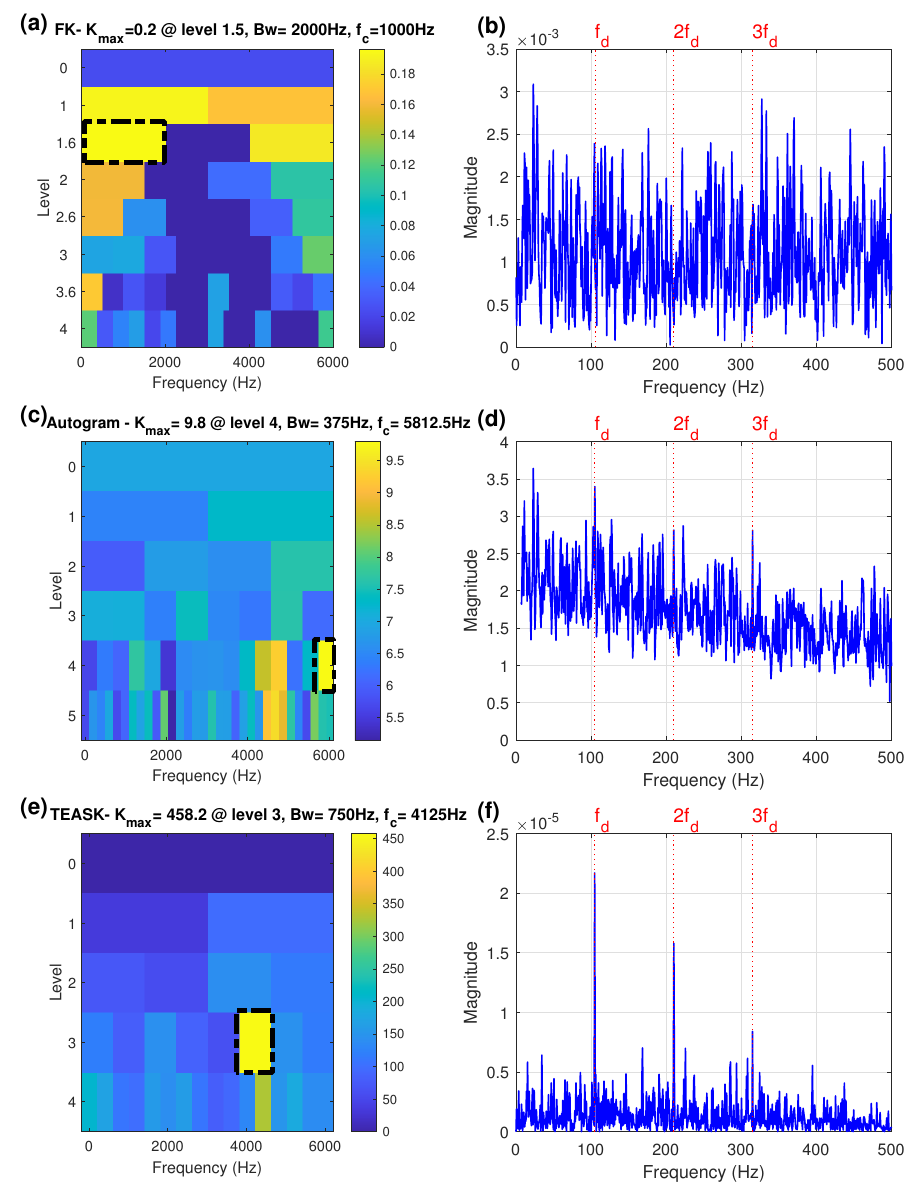
Figure 4. The simulation signal ( a ) the FK, ( b ) the SES obtained by the node with highest kurtosis of the FK, ( c ) the Autogram, ( d ) the combined SES obtained by the node with highest kurtosis of the Autogram, ( e ) the TEASK, ( f ) the TEPS obtained from the node with highest kurtosis of the TEASK. (Red dotted lines: defect frequency component of 105 Hz ( f d ) and its harmonics; black dash-dot rectangle indicates the optimal frequency